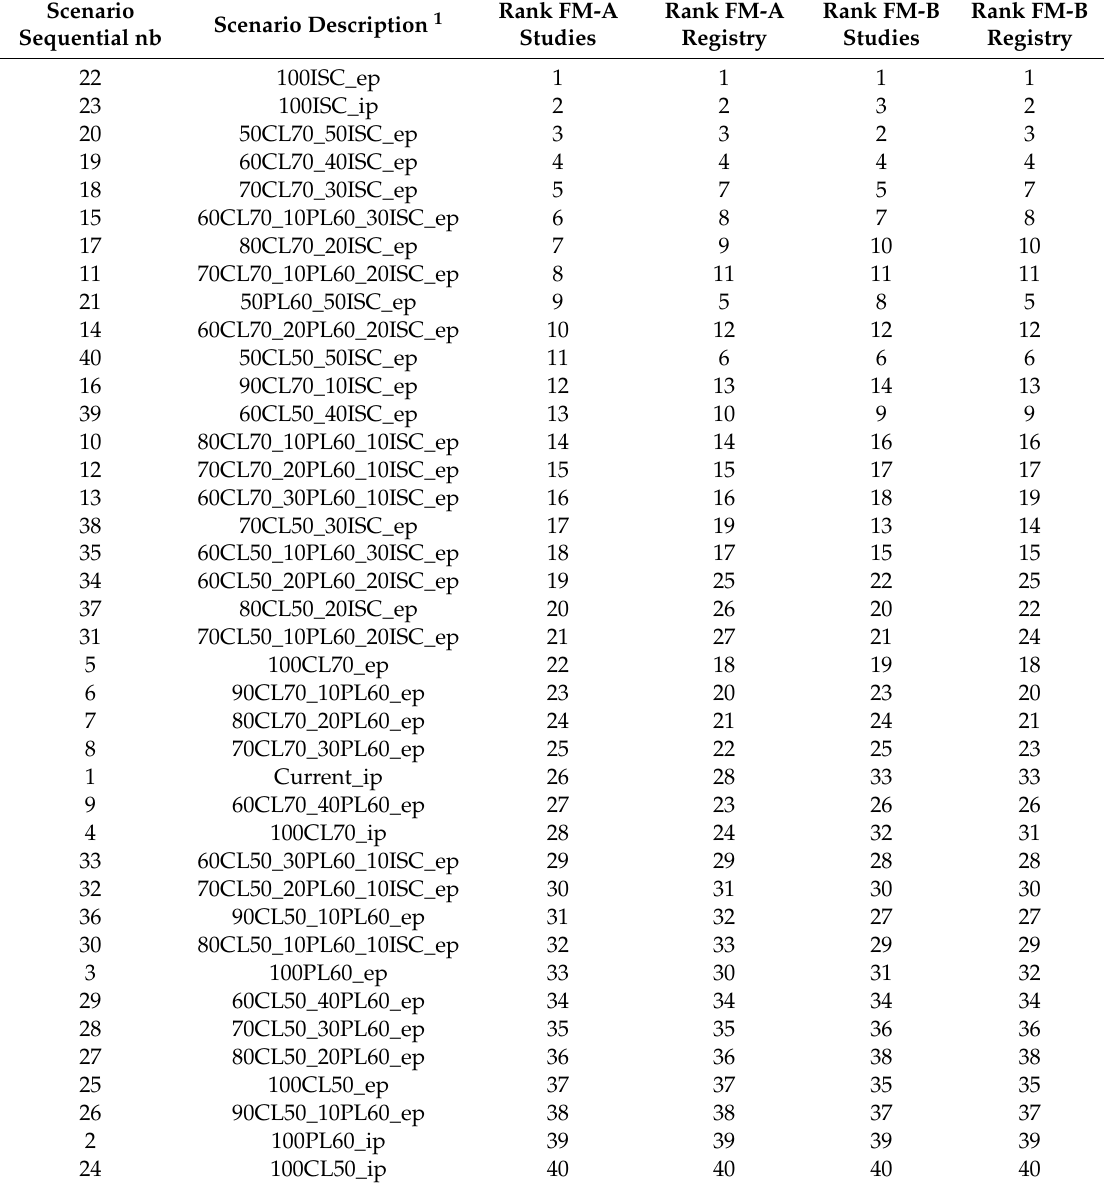
Table 4. Scenario ranking resulting from the use of the two reference data sets for FM-A and FM-B, sorted in descending order of their naturalness